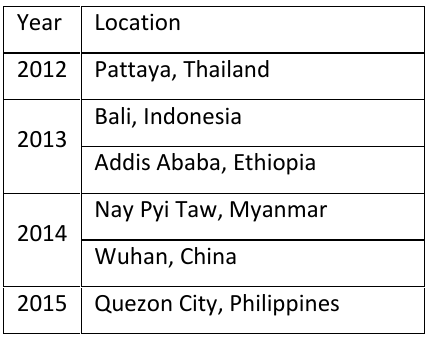
Table 2. Summary of the locations of the last six SC summer schools Four summer schools were organised right after the annual Asian Conference on Remote